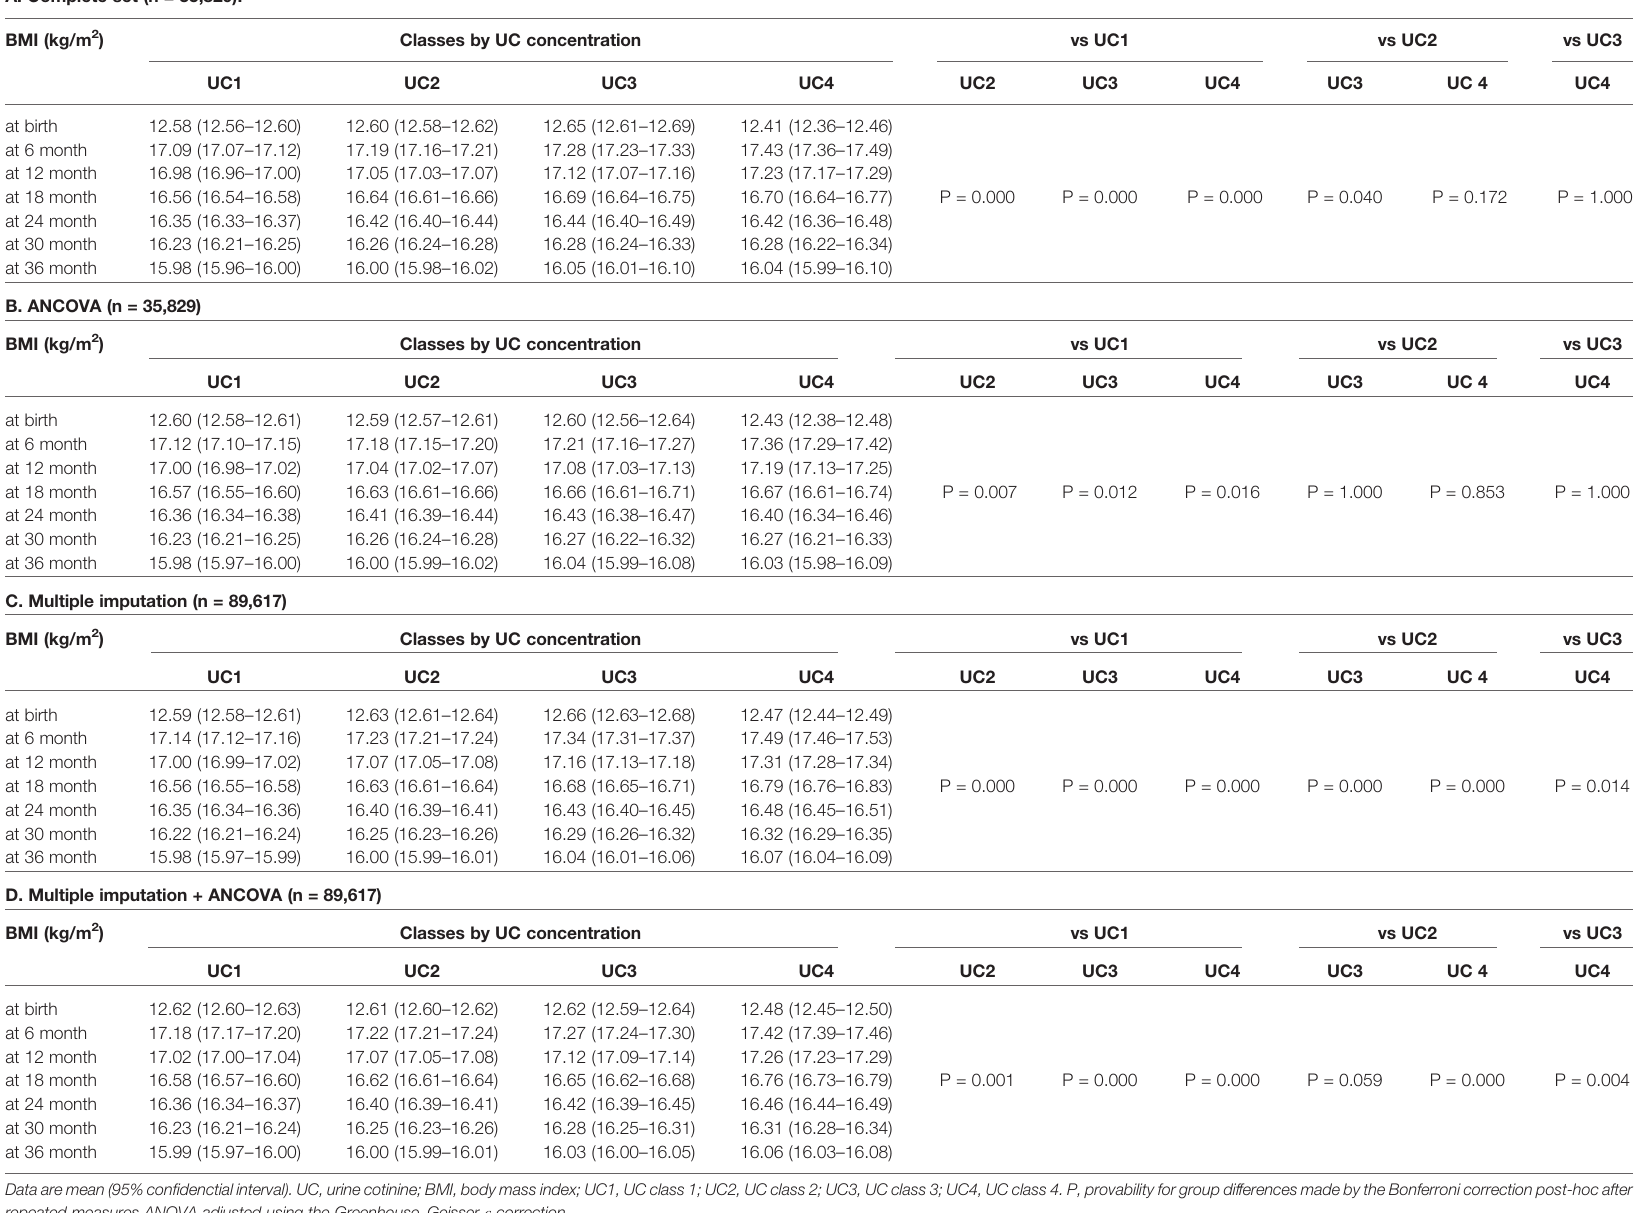
TABLE 2 | Trends in body mass index (BMI) of participants in urinary cotinine (UC) classes before (n=35,829) and after (n= 89,617) multiple imputation. A. Complete set (n =